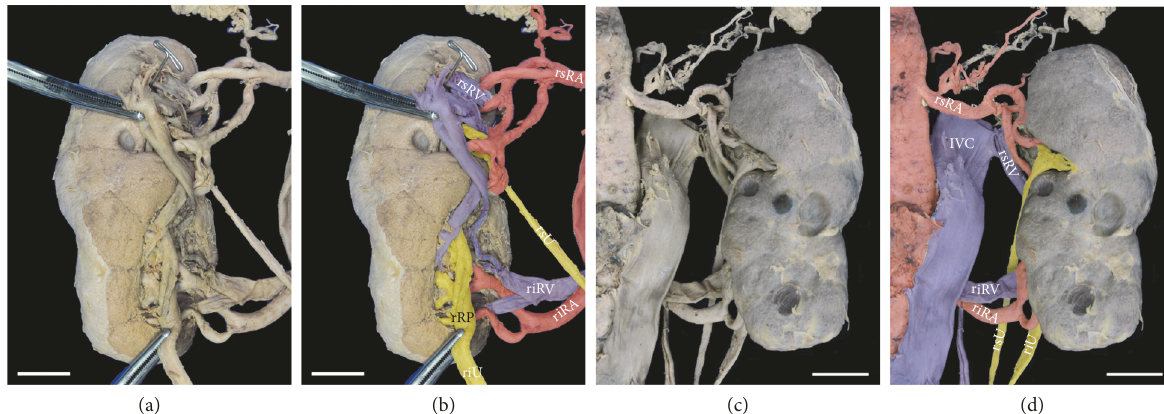
Figure 4: Ex situ right kidney exhibits anatomical variations . Anterior (a, b) and posterior (c, d) views of the right kidney. Arterial, venous, and ureteric systems (b, d) are pseudocolorized in red (arterial), blue (venous), and yellow